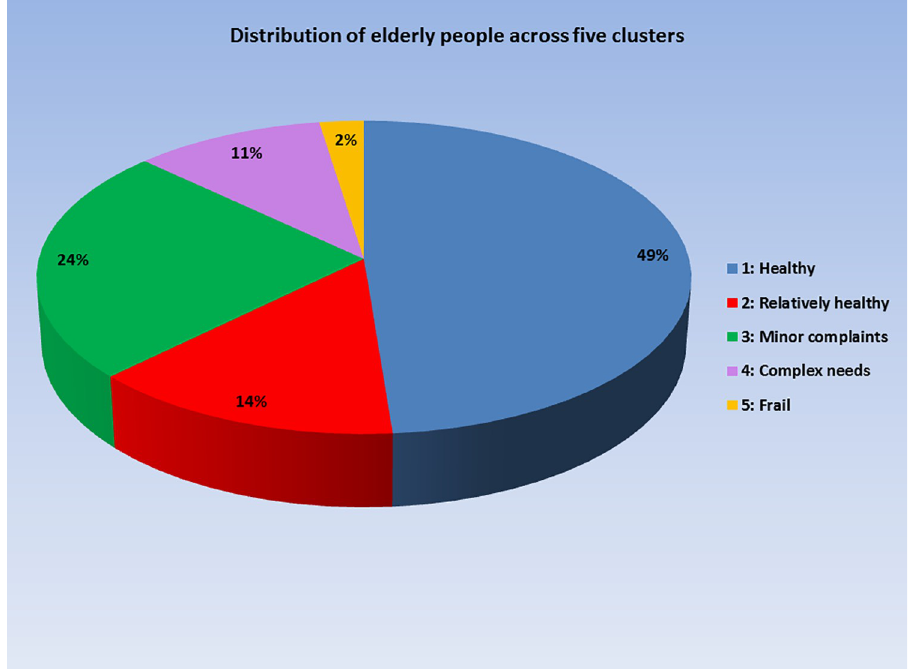
Fig 1. Distribution of elderly people across five